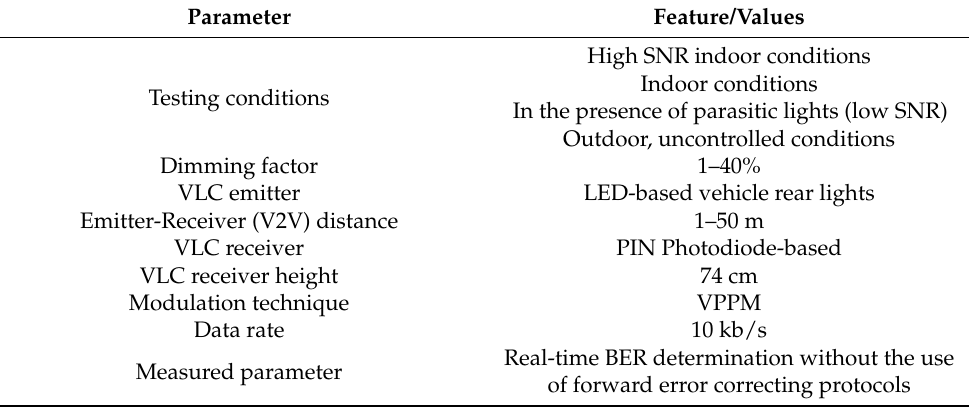
Figure 9. Spectral analysis of the incandescent light noise source used during the tests. The outdoor tests have been performed in uncontrolled daylight conditions on a mostly sunny day. In this case, the range could be increased up to 50 m, while the sun gen- erated a variable noise component which reached values between 3200 and 50,000 µ W/cm 2 at the VLC receiver level. The summary of the experimental setup, the parameters of the parasitic light source, and the materials used during the experimental evaluation are presented in Tables 4–6, whereas Figure 10 illustrates the experimental methodology. Table 4. Summary of the experimental parameters.